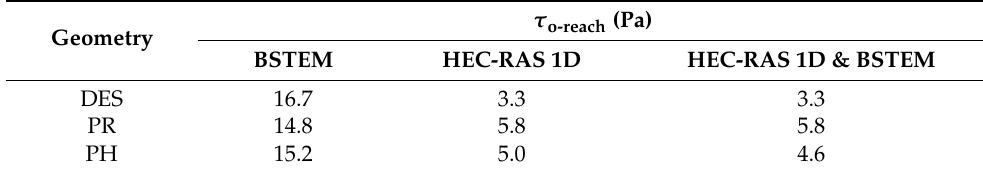
Table 5. Reach-averaged values of τ o ( τ o-reach ) for the Design (DES), Post-Restoration (PR), and Post-Hurricane (PH) geometries as predicted by BSTEM, HEC-RAS 1D, and HEC-RAS 1D & BSTEM. Geometry